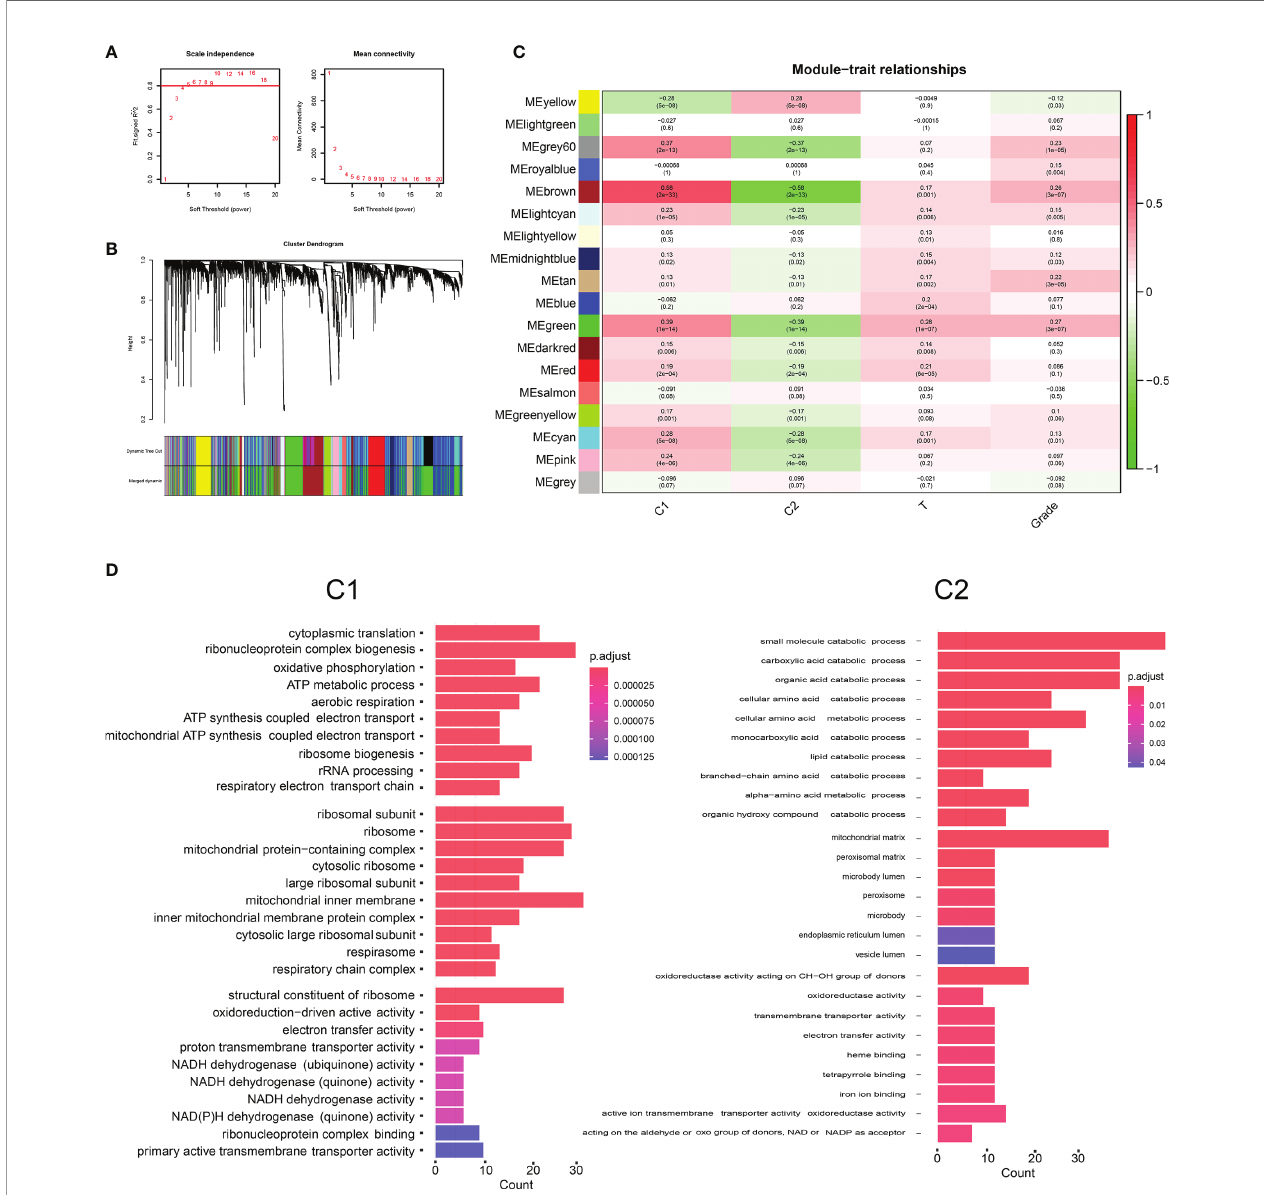
FIGURE 3 | (A) Network topology analysis for different soft threshold powers. (B) A hierarchical clustering tree was constructed, with each leaf representing a gene and each branch representing a co-expression module. A total of 18 co-expression modules were generated. (C) The correlation coef fi cients between two molecular phenotypes, T stages, grade, and co-expression modules. (D) The primary enrichment biological pathways of co-expression modules of two molecular